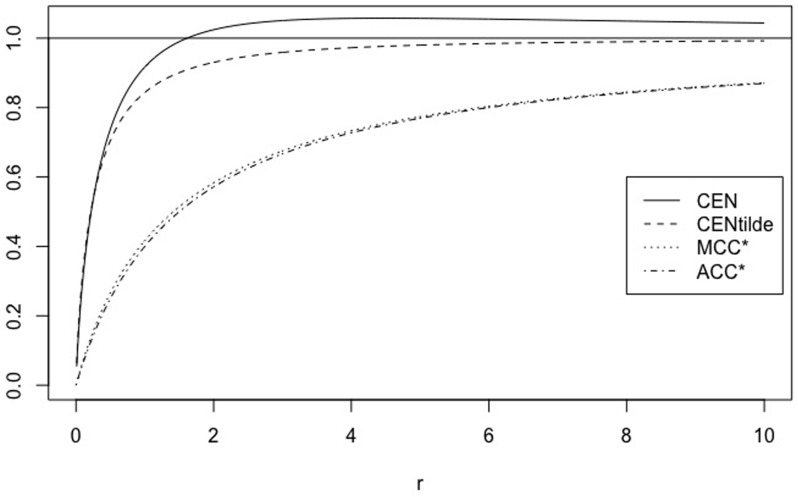
Family XA, r.CEN, MCEN, ACC* and MCC* as function of r > 0 for A = 0.5.